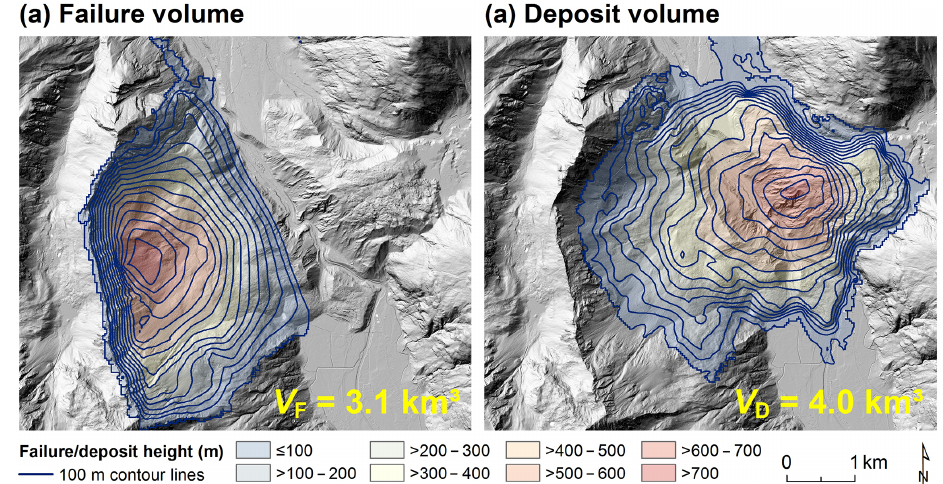
Figure 7. (a) Failure and (b) deposition heights and volumes of the Köfels rockslide mass computed in ArcGIS. The contour lines indicate the height difference between the (a) pre-failure and (b) post-failure topography and the topography of the sliding surface.